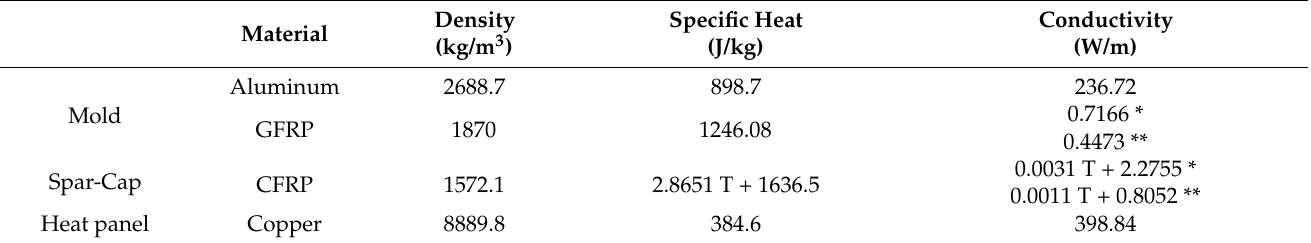
Table 2. Thermophysical properties of materials related to heat transfer